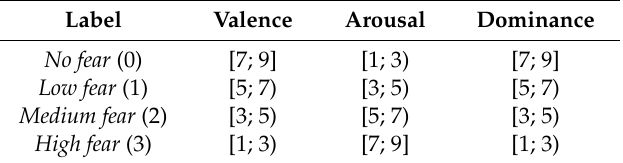
Table 2. Division of valence, arousal and dominance for the four-level fear evaluation modality. Label Valence Arousal